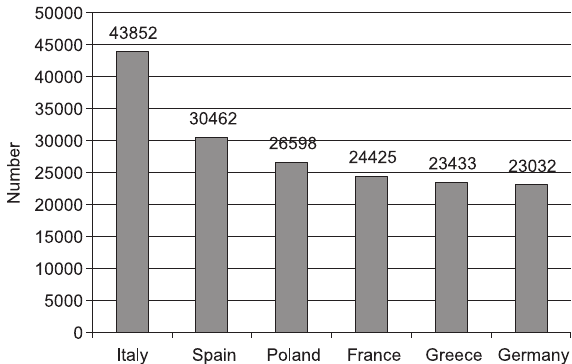
Fig. 3. Number of organic farms in selected EU states in 2014.